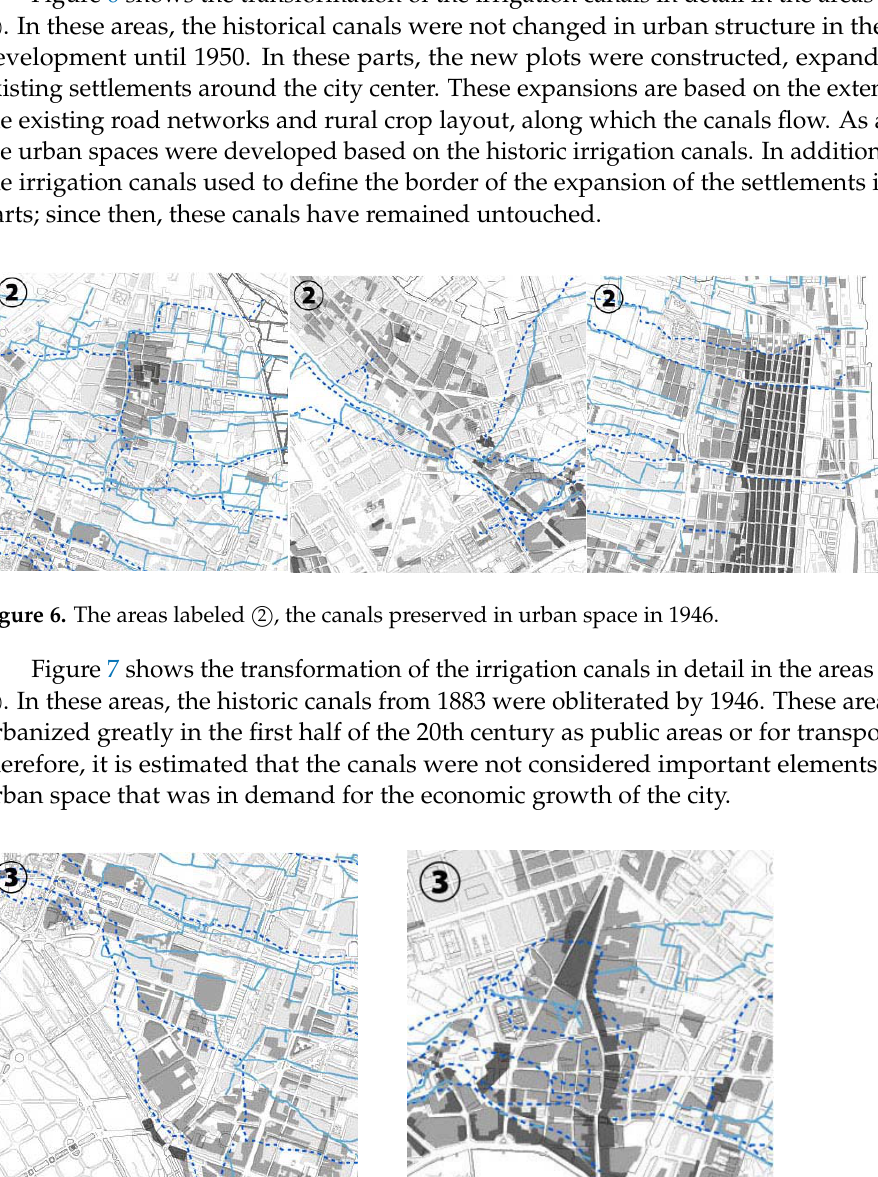
Figure 5. The areas labeled ①, the canals preserved their layout from 1883 to 1946. The canals in these areas are still used for agricultural irrigation systems.